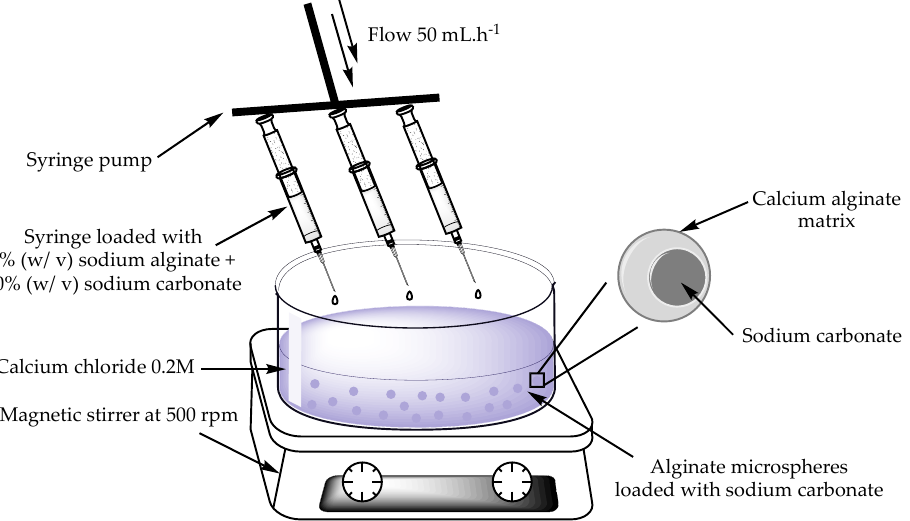
Figure 8. Schematic representation of the microencapsulation of sodium carbonate in sodium alginate. Figure generated using ChemDraw 15.1.